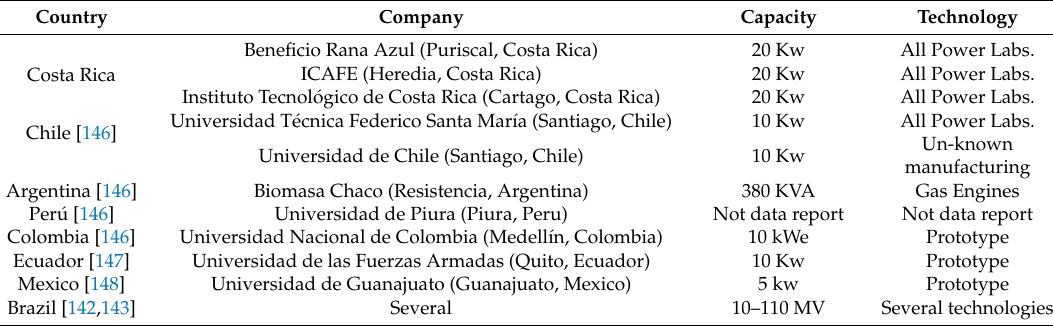
Table 3. Presence of gasifiers in some countries of Latin